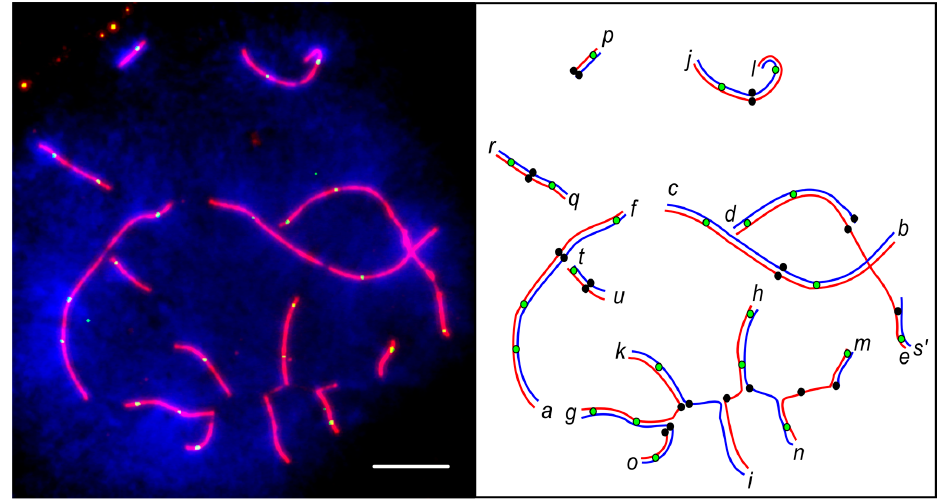
Figure 6. Fluorescent microphotograph and interpretative diagram of pachytene spermatocyte of a CVIII heterozygote after immunolocalisation of SYCP3 (red) and MLH1 (green), and DAPI counterstaining (blue). Centromeres are marked with black circles on the diagram. MLH1 foci marked with green circles. Letters indicate distal ends of the chromosome arms. Scale bar 5 µm.